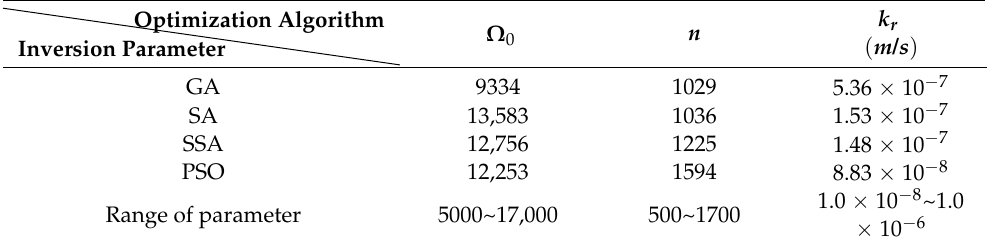
Table 4. Results of the simulated parameters for four algorithms. ParameterOptimization Algorithm Inversion